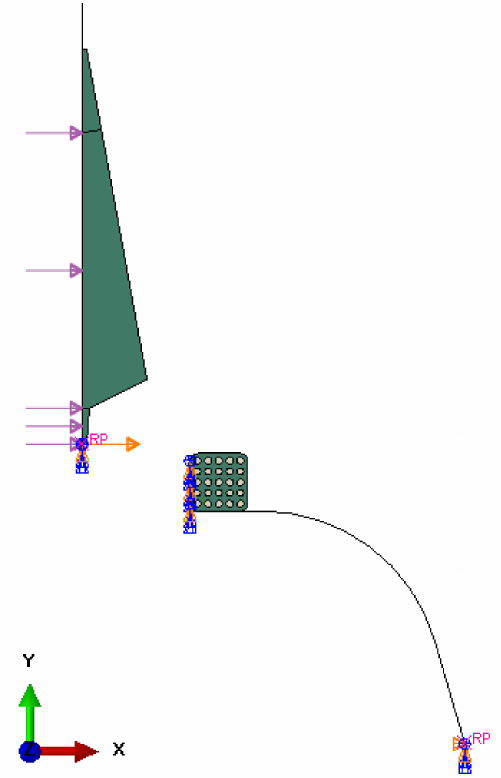
Figure 6. Boundary conditions and loads.